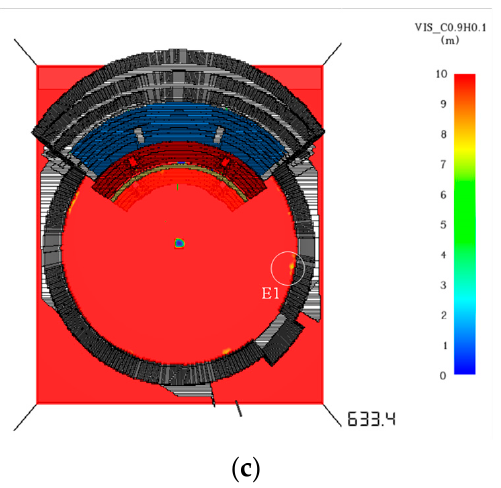
Figure 15. Contour of visibility at the height of 2 m with smoke exhaust off. ( a ) Contour of visibility on the third floor at 379.6 s; ( b ) contour of visibility on the second floor at 520.7 s; ( c ) contour of visibility on the first floor at 633.4 s. Table 5. Time required for each characteristic index to reach critical